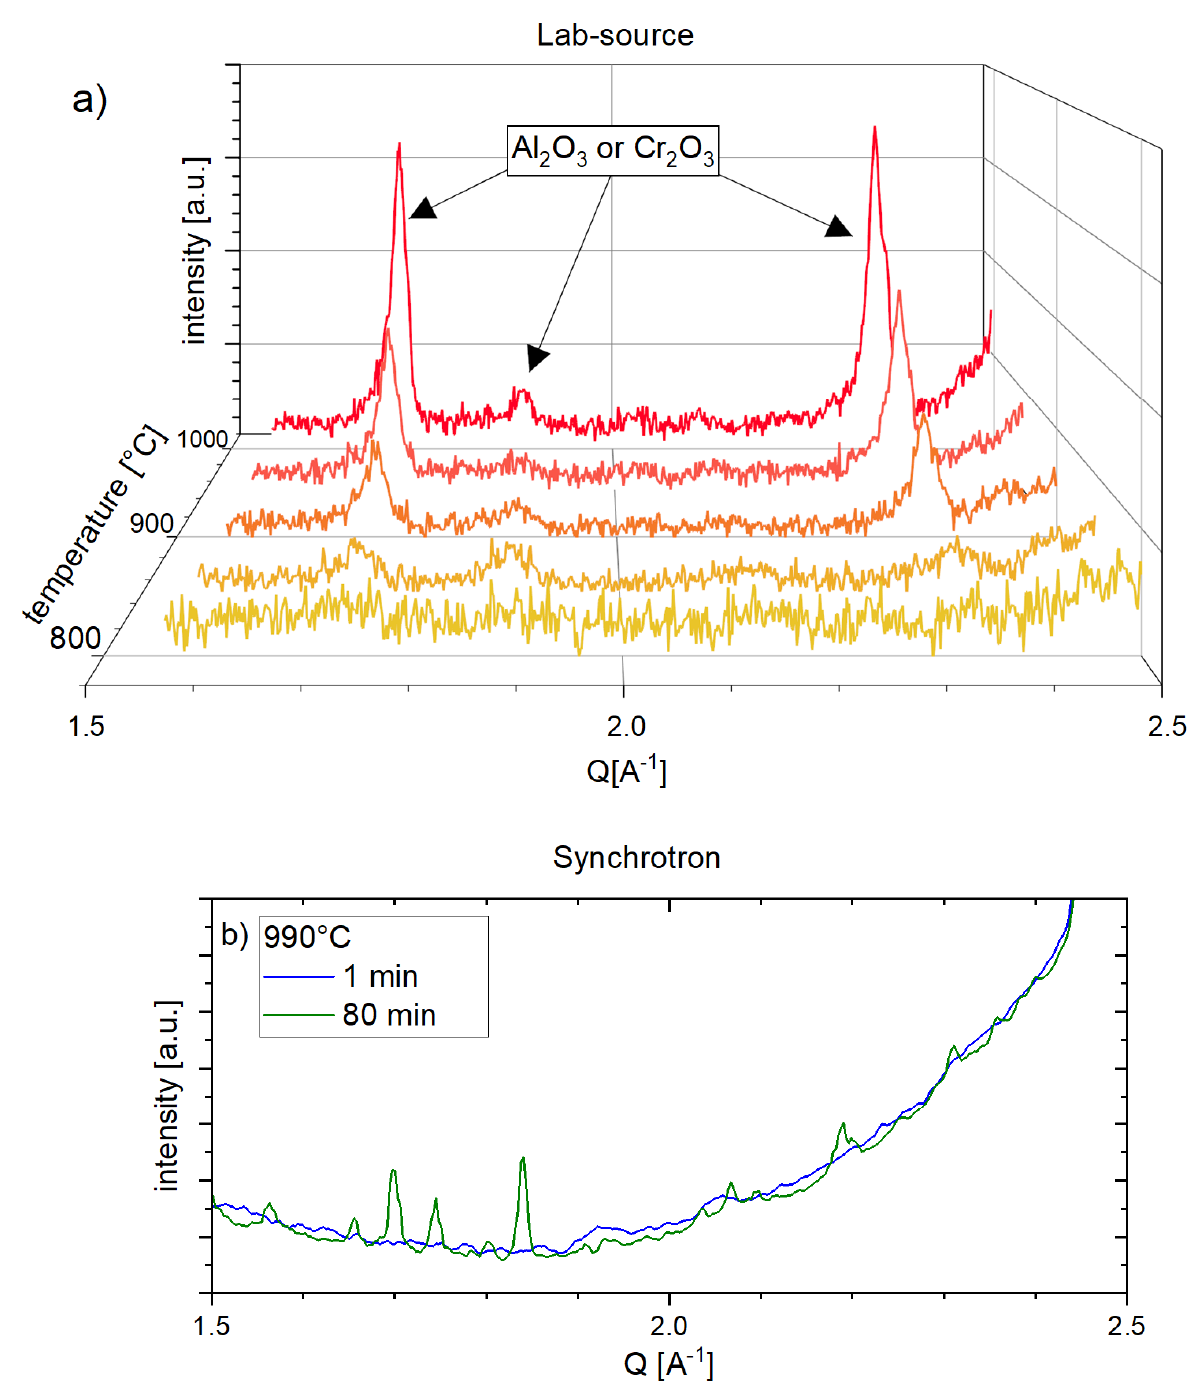
Figure 10. Low Q-range diffraction pattern showing the evolution of different oxide phases (Al 2 O 3 or Cr 2 O 3 ) measured during ( a ) lab-source and ( b ) synchrotron diffraction of VDM ® Alloy 780 in the temperature range 800 °C to 1000 °C and for holding segment at 990 °C.